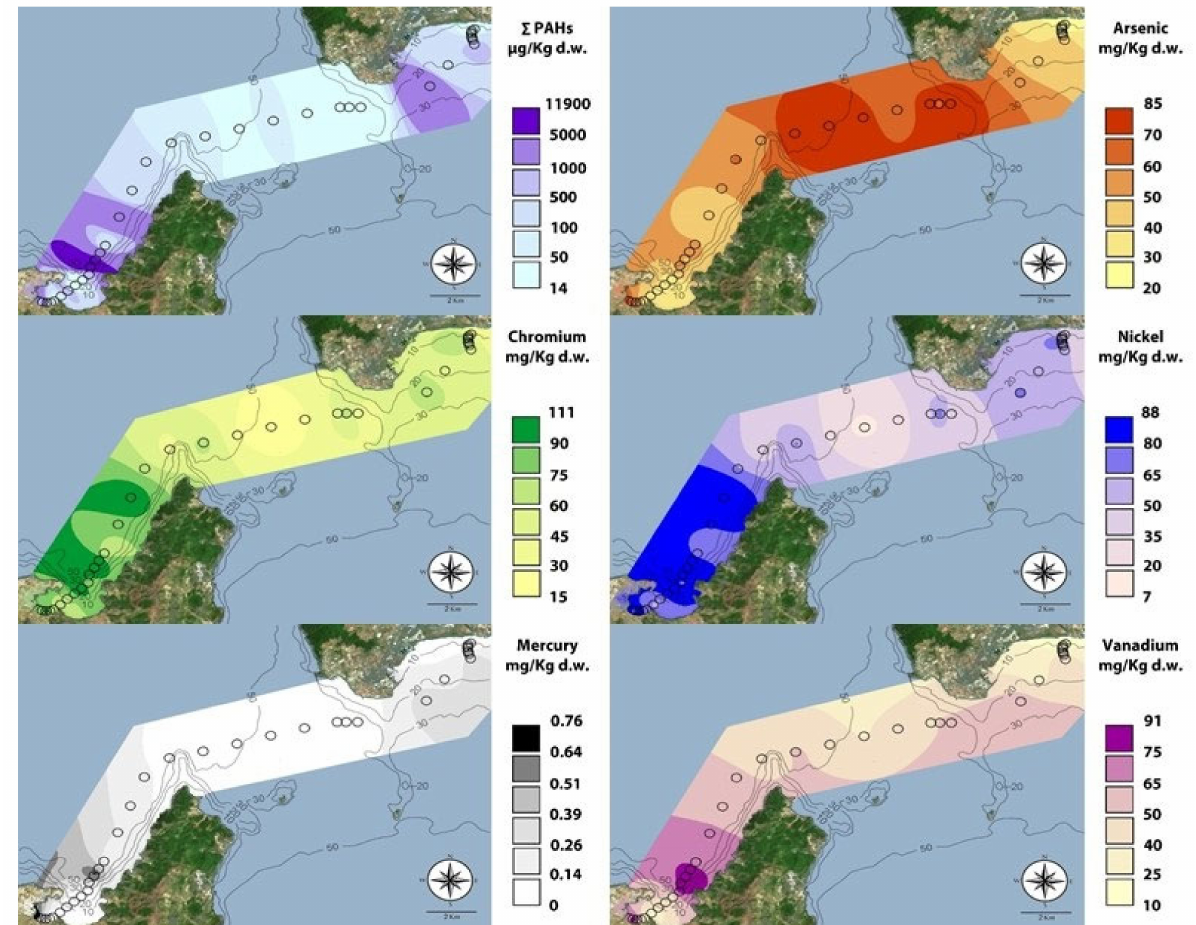
Figure 5. Concentration of selected pollutants ( Σ 16PAH, As, Cr, Ni, Hg, V) in the Piombino